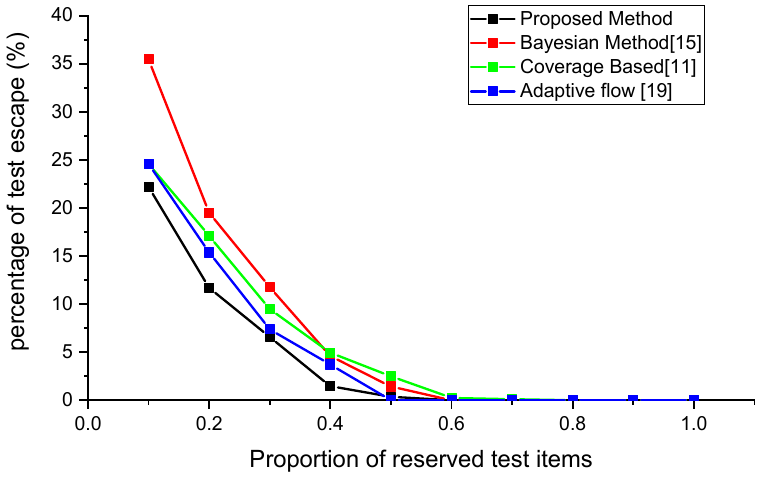
Figure 7. Test escape comparison.